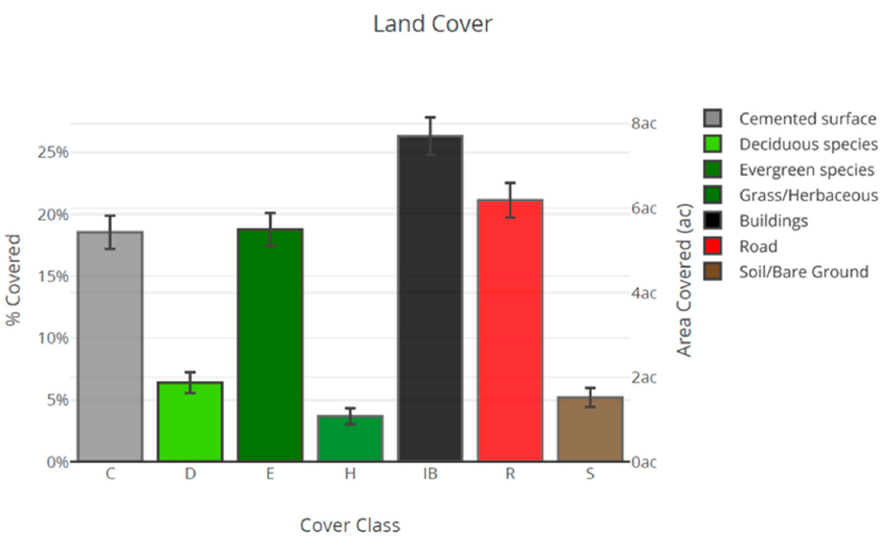
Figure 6. Details of cover classes with their respective cover percentages (from i-Tree Canopy report). Table 2. Economic benefits of CO 2 storage (expressed in tons) and removal of air pollutants by trees (from i-Tree Canopy